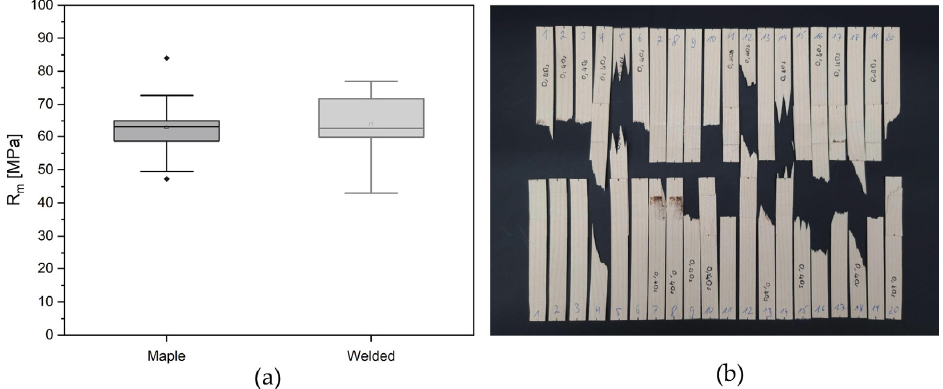
Figure 6. Tensile strength tests: ( a ) Comparison graph of maple veneer’s tensile strength to welded joints’ tensile strength; ( b ) Tested welded veneer samples.